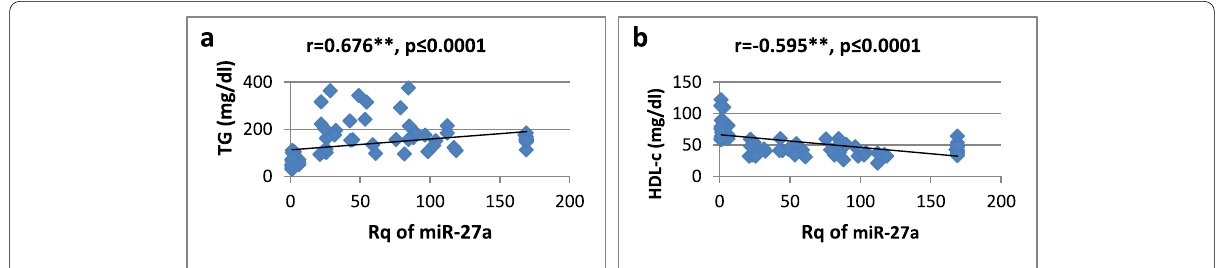
0.676) and HDLCholesterol ( r =